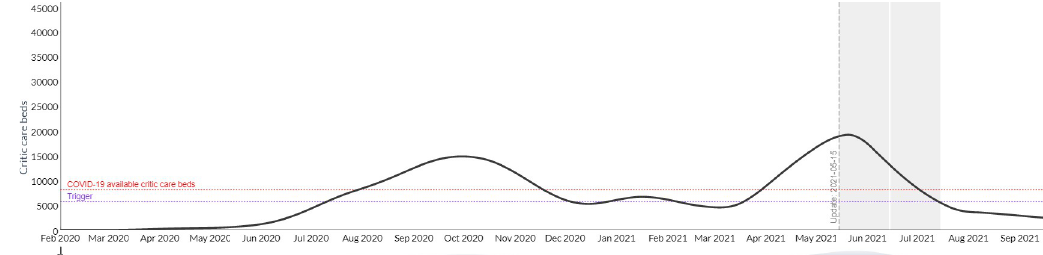
Fig 7. Simulation of the use of intensive care beds for Argentina based on a scenario of constant R_0 with a triggered intervention upon reaching 70% occupancy of intensive care beds